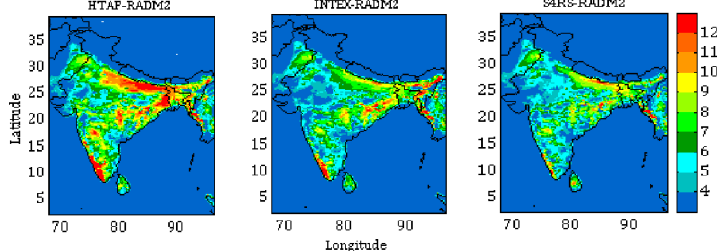
Figure 4. Net daytime surface ozone chemical tendency (in ppbvh − 1 ) for the month of April during 06:30–12:30IST.